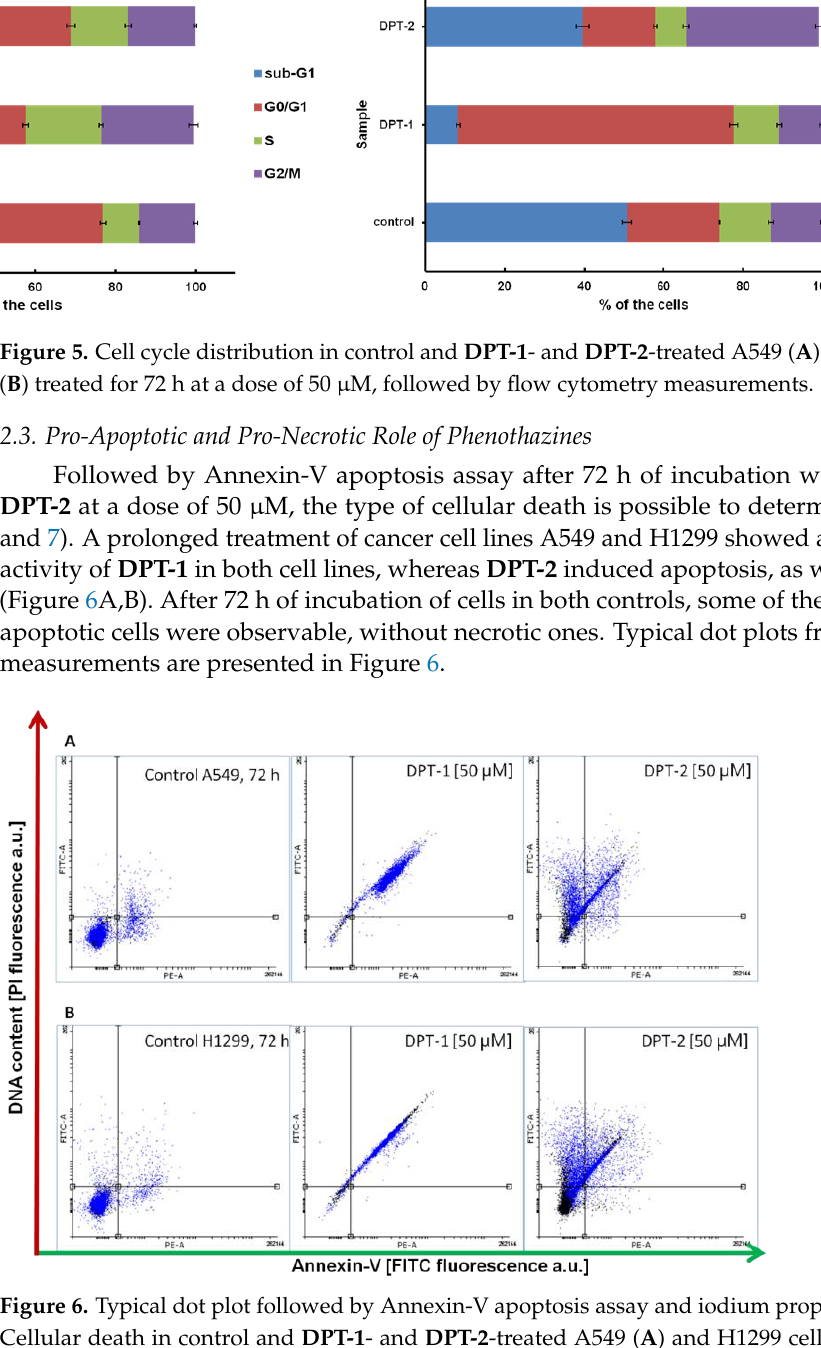
Figure 6. Typical dot plot followed by Annexin-V apoptosis assay and iodium propide (PI) staining. Cellular death in control and DPT-1 - and DPT-2 -treated A549 ( A ) and H1299 cells ( B ) treated for 72 h at a dose of 50 µM, followed by flow cytometry measurements (normal cells: Annexin-VI − /PI − ; early apoptosis: Annexin-V + /PI − ; late apoptosis: Annexin-V + /PI + ; necrosis: Annexin-V − /PI + ).